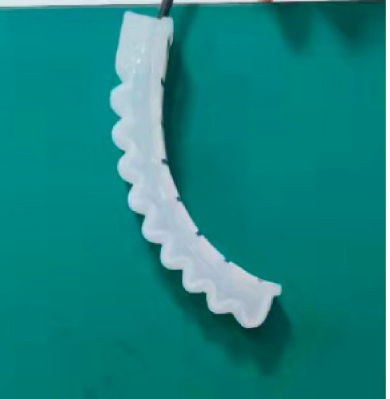
Figure 15. Air tightness check of soft